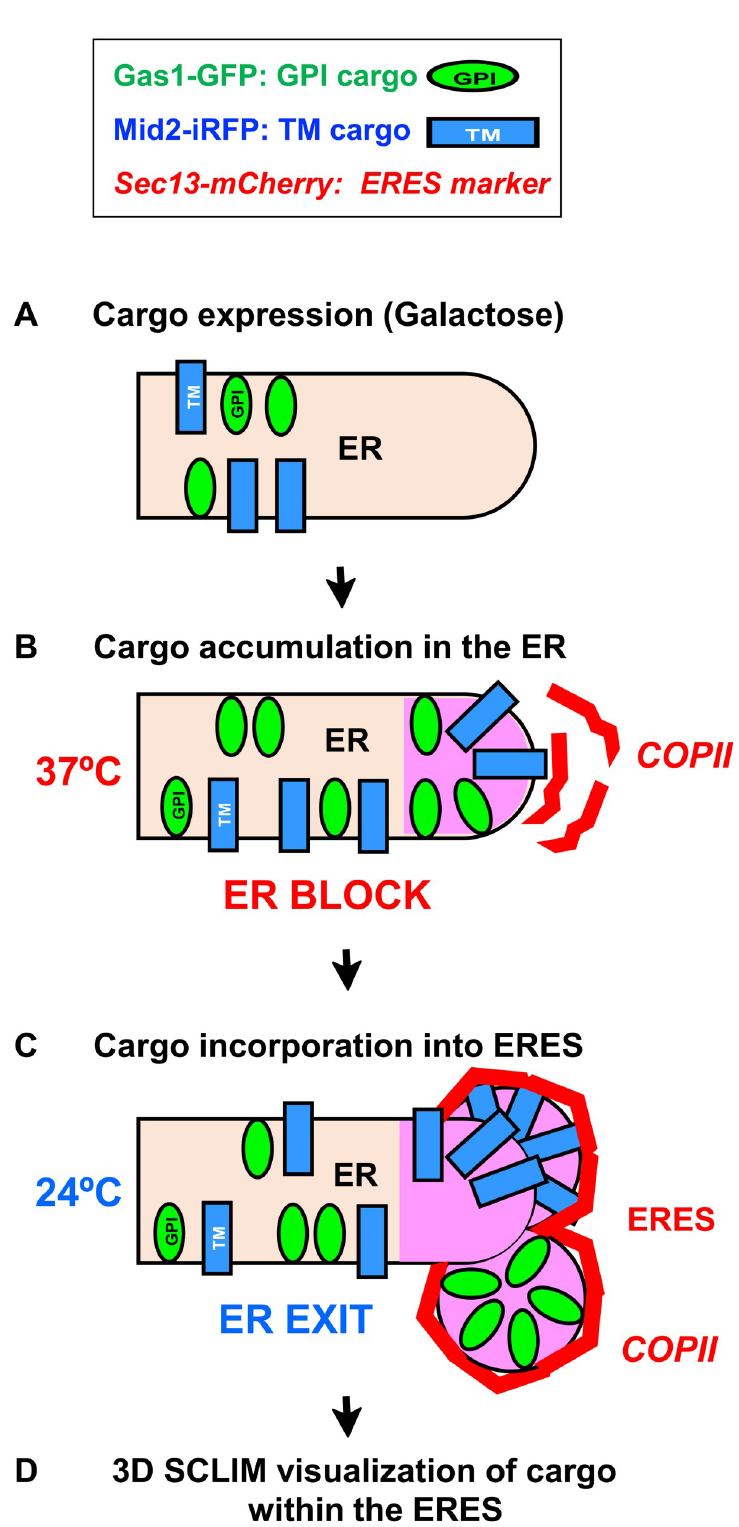
Fig 1. Protocol flow chart. (A) Galactose-induced co-expression of the GPI-anchored cargo Gas1-GFP (green) and the transmembrane (TM) cargo Mid2-iRFP (blue) in the sec31-1 temperature-sensitive COPII mutant strain constitutively expressing the ERES marker Sec13-mCherry (red). (B) Accumulation of Gas1-GFP and Mid2-iRFP at